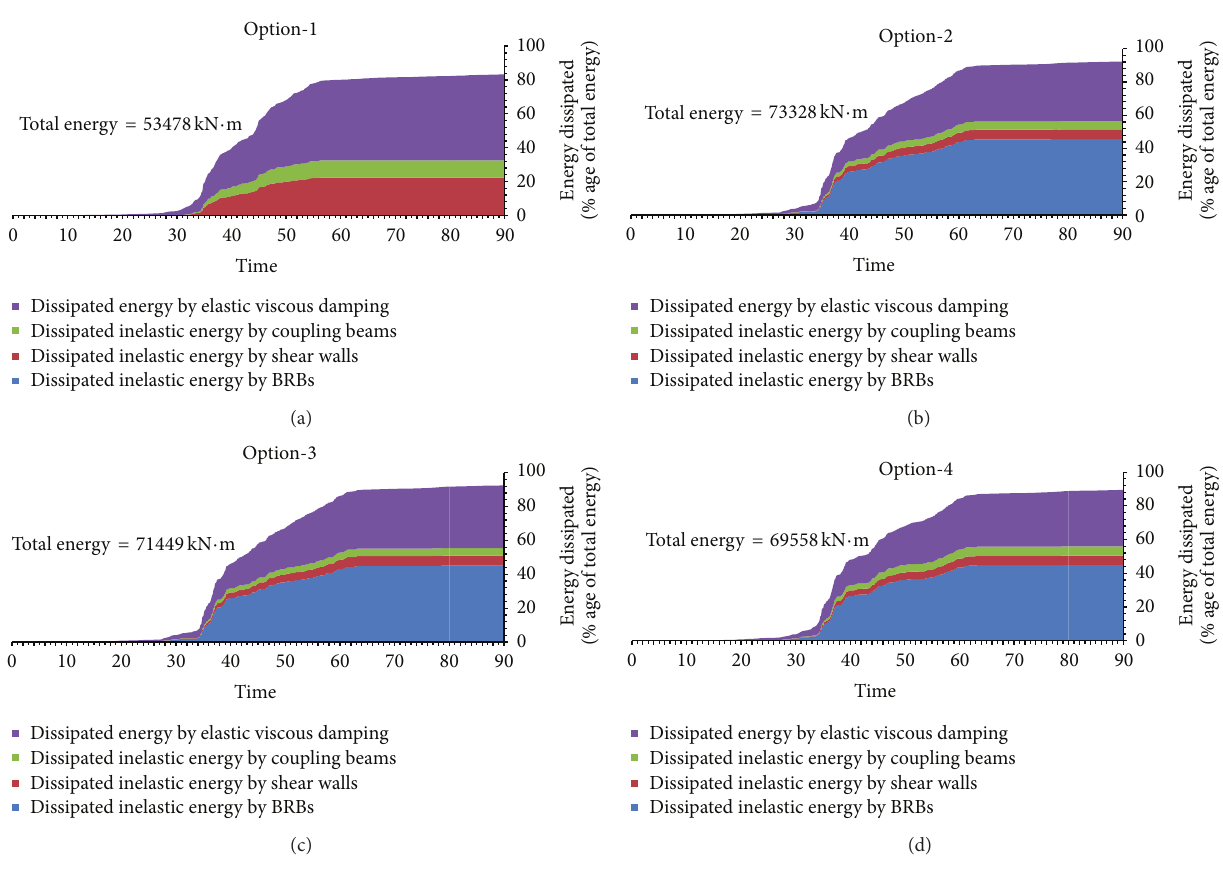
Figure 15: Inelastic energy demands in structural components. (a) to (d) For Option-1 to Option-4, respectively.